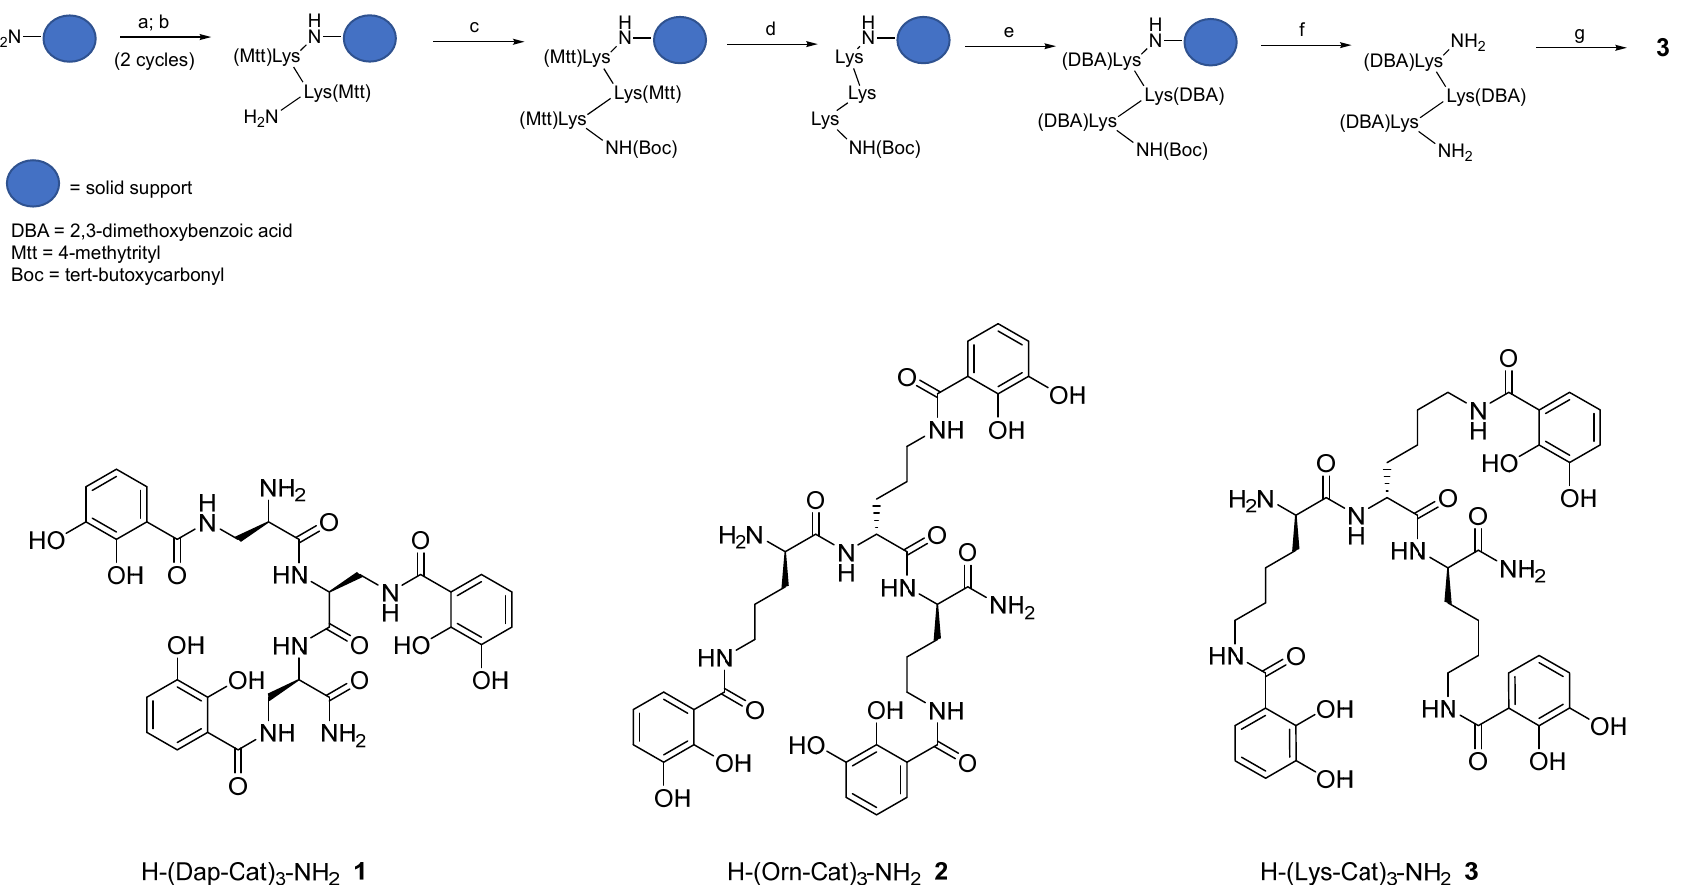
Figure 2. Schematic route for the synthesis of hexadentate peptide-chelator 3 : (a) Fmoc-Lys(Mtt)-OH, Oxyma, N,N’-diisopropylcarbodiimide (DIC), DMF; (b) 20% piperidine / DMF; (c) Boc-Lys(Mtt)-OH, Oxyma, DIC, DMF; (d) 1% TFA / DCM; (e) 2,3-dimethoxybenzoic acid (DBA), PyOxP / DIPEA, DMF; (f) TFA; (g) BBr 3 /